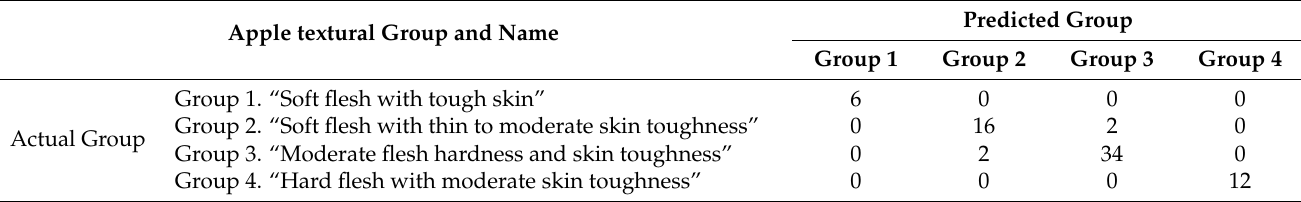
Table 3. Classification accuracy matrix for four apple textural groups based on the linear discriminant analysis using five selected TA.XT plus parameters ( n =